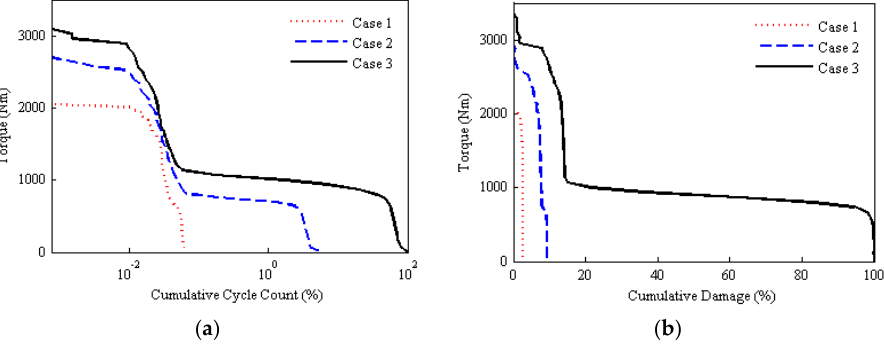
Figure 11. Fatigue damage analysis of the engine output shaft torque for shaft parts: ( a ) torque vs. cumulative cycle count (%); ( b ) torque vs. cumulative damage (%).